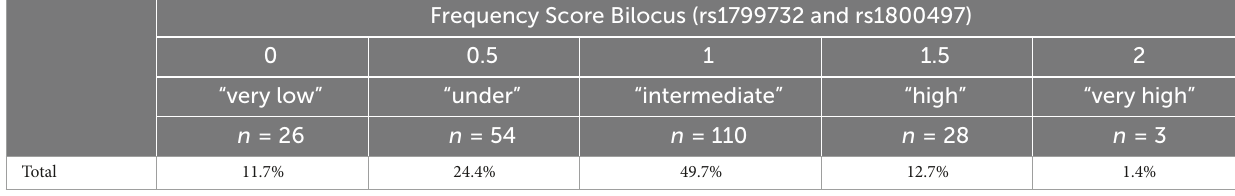
TABLE 4 Frequency of Score Bilocus (rs1799732 and rs1800497) in Chilean university students.